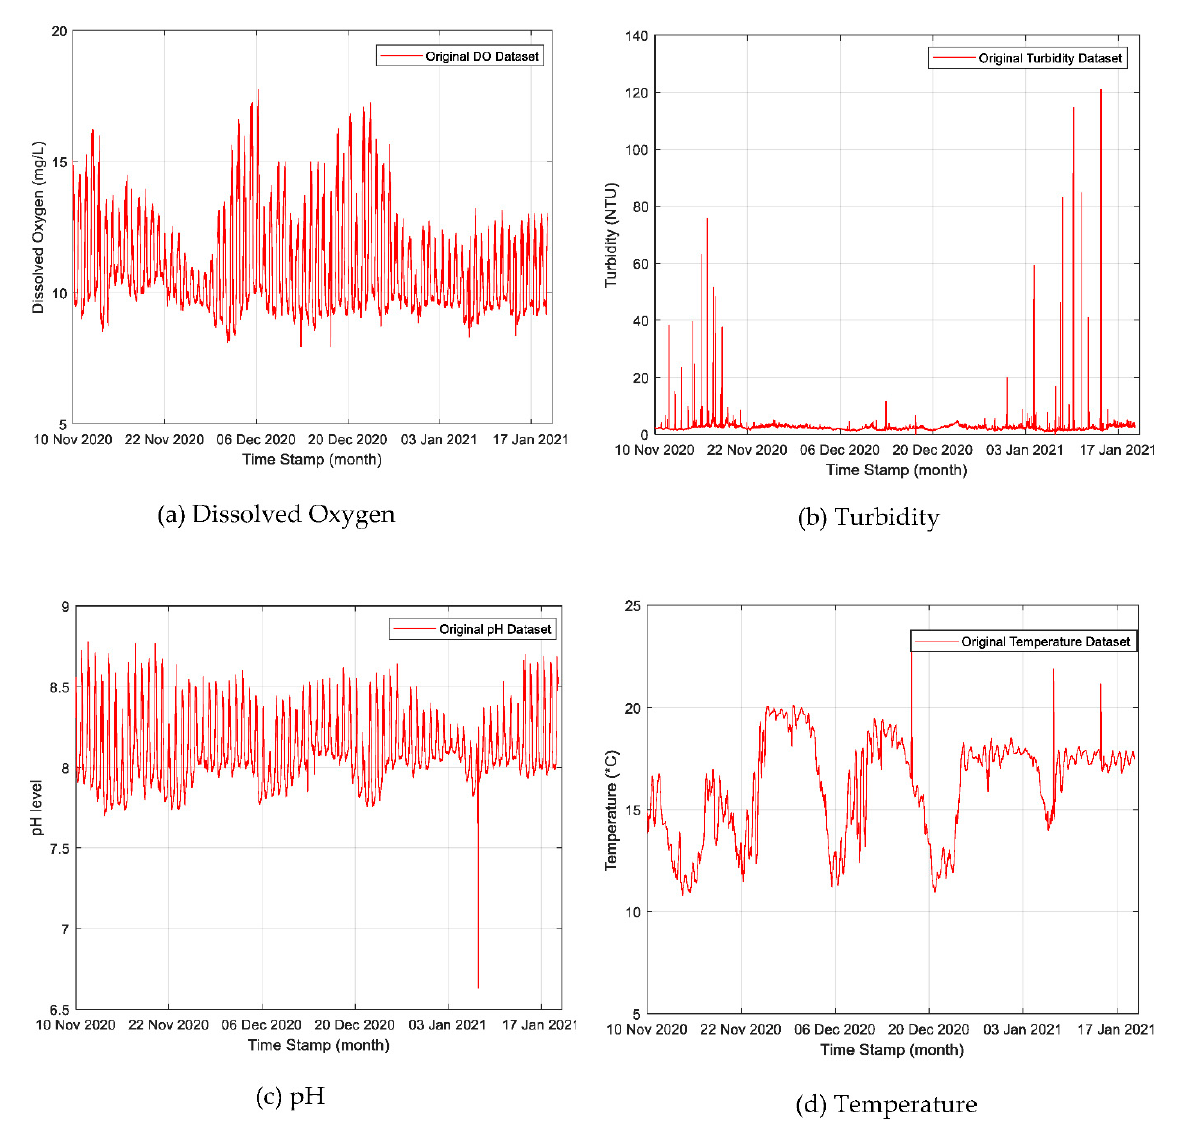
Figure 2. The trend variation of the water quality parameters time-series datasets from the Abalone farm in South Africa: ( a ) dissolved oxygen, ( b ) turbidity, ( c ) pH, and ( d ) temperature.